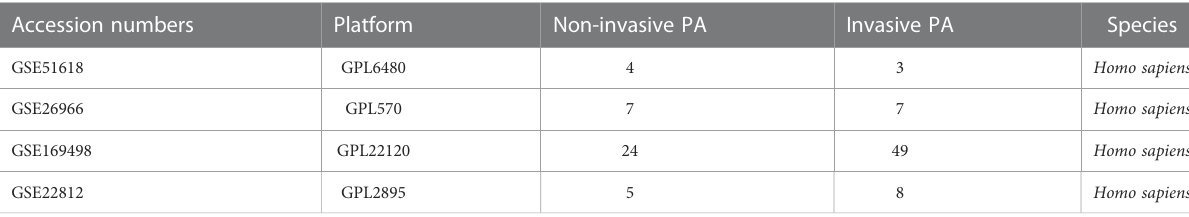
TABLE 1 Information relating to the four microarray